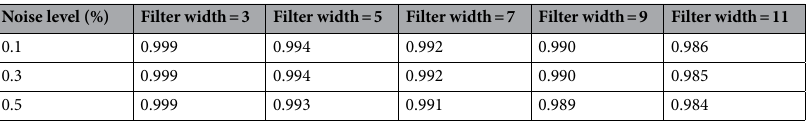
Table 2. Comparison of the SSIM values of each noise level image filtered using each filter size abwFMGFI.